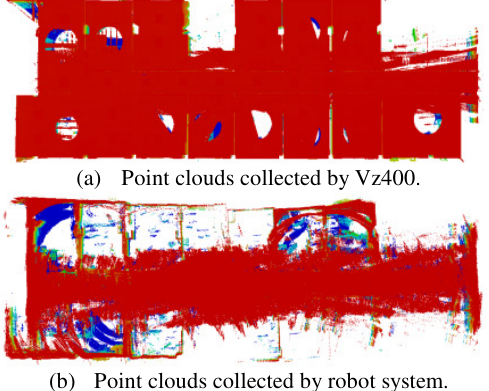
Figure 3. Point clouds of the experiment indoor